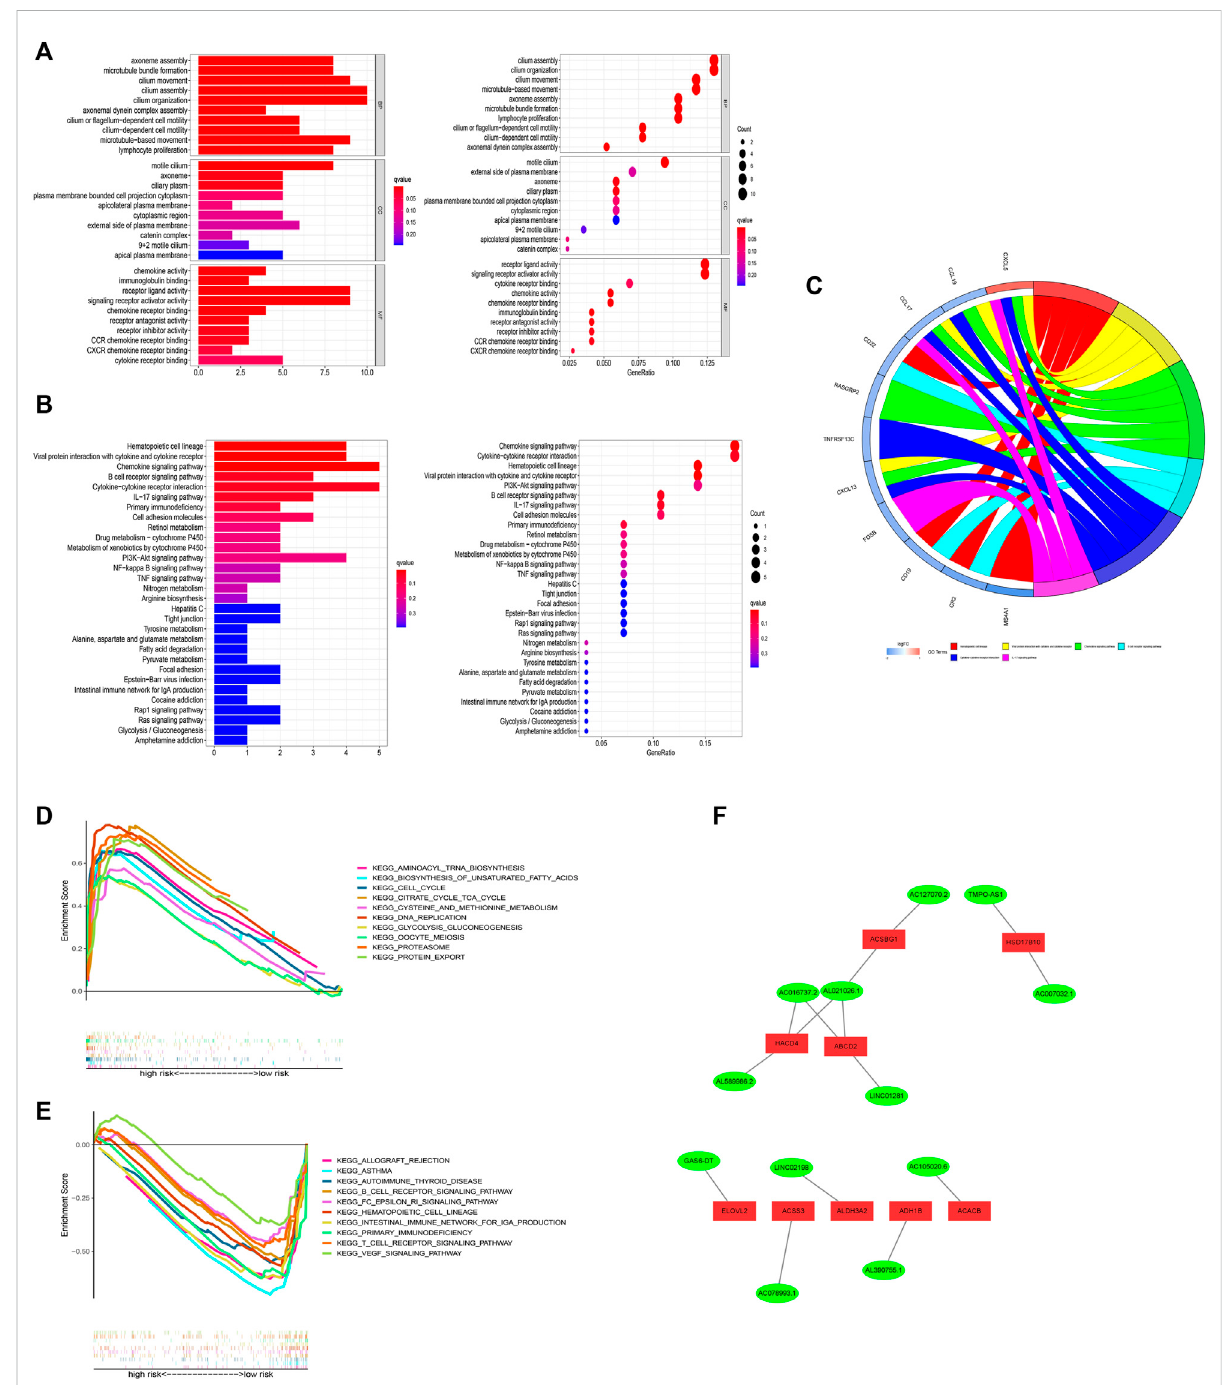
FIGURE 11 Functional analysis. (A) Result of GO functional enrichment (top 10). (B) KEGG enrichment terms (top 30). (C) Circle diagram in KEGG analysis. (D) GSEA of the top 10 pathways signi fi cantly enriched in the high-risk group. (E) GSEA of the top 10 pathways in the low-risk group. (F) 12 FAM- related lncRNAs and differential FAM genes